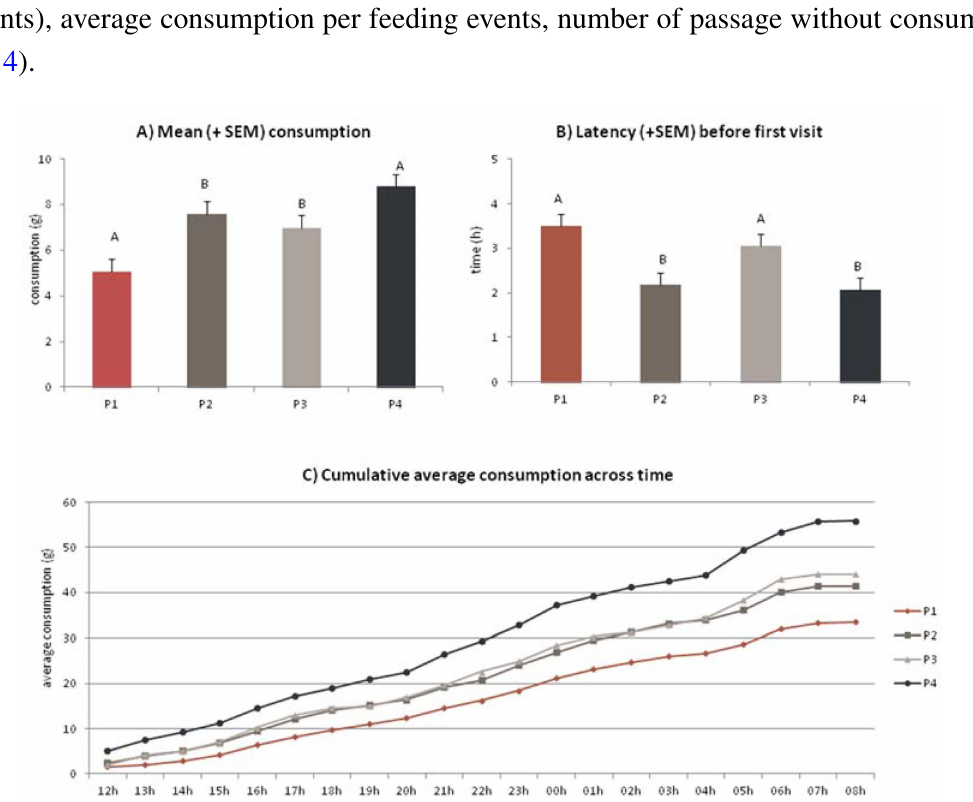
Figure 4. Four dry cat foods, differing only by the composition of the palatability enhancer applied in coating, were evaluated in sequential monadic conditions by a 40 cats expert panel (Panelis). Individual data such as time and quantities eaten were recorded automatically during a 20 h period. ( A ) average consumption per passage (adjusted mean +SEM); ( B ) average time before the first visit (adjusted mean + SEM); and ( C ) cumulative average consumption across time. Differing letters identify significant differences between the products ( p <